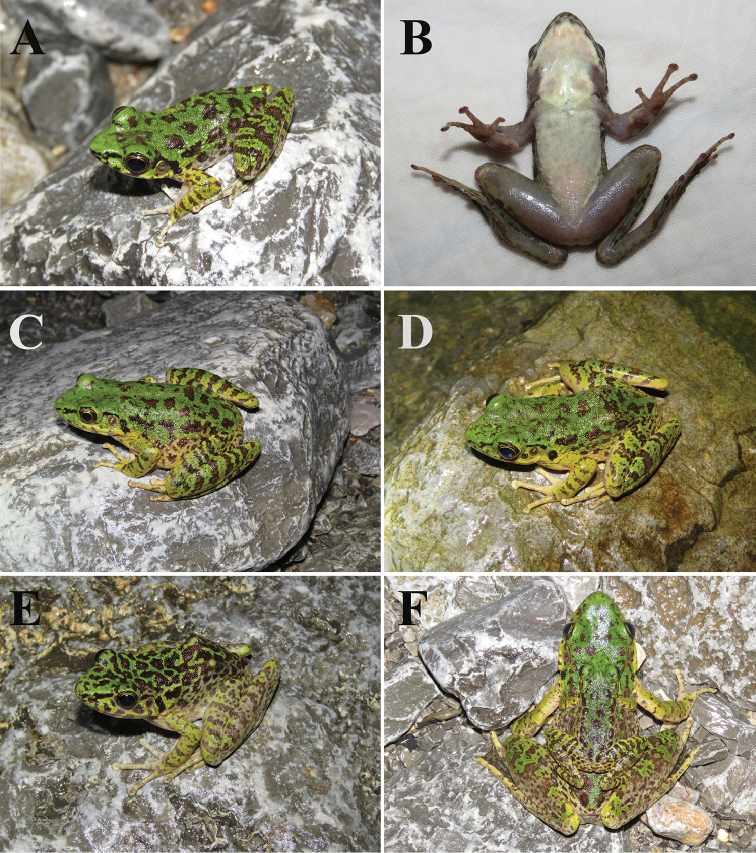
Morphology and colour pattern of living Odorrana
sangzhiensis sp. nov. A dorsolateral view of the holotype CSUFT 4308220051 B ventral view of the holotype CSUFT 4308220051 C dorsolateral view of a gravid female (CSUFT 4308220047) D dorsolateral view of adult female E variation in morphology and colour pattern of an adult female (CSUFT 4308220048) F reproductive behaviour of Odorrana
sangzhiensis sp. nov.